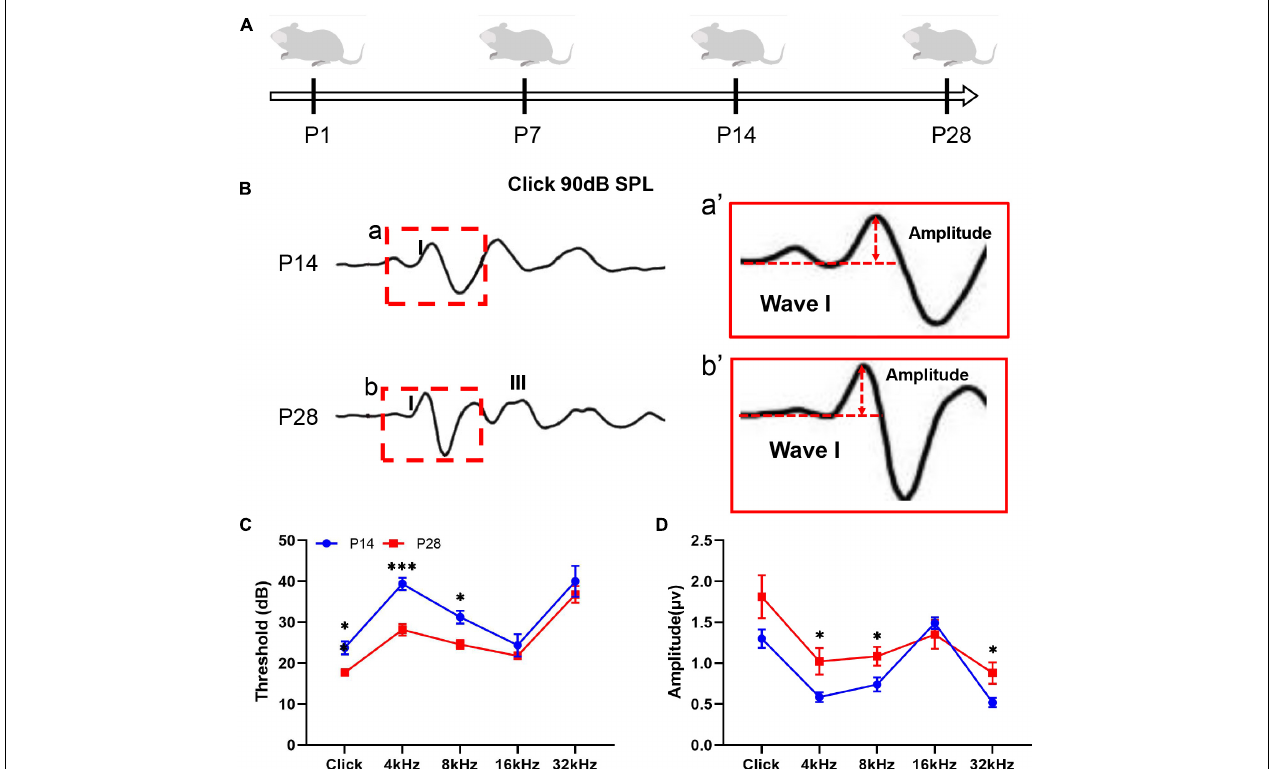
FIGURE 1 | Hearing detection corresponding to developing cochlea. (A) Schematic diagram of the experimental procedure and time points for hearing detection. Hearing function in the mice was estimated by detecting the ABR threshold and ABR wave I amplitude at P14 and P28. (B,a,b) A visible ABR waveform was observed at P14 and P28; the red dashed frame indicates ABR wave I. (a (cid:48) ,b (cid:48) ) A larger amplitude of ABR wave I was found at P28 than at P14. (C) Compared with P14, significantly reduced ABR thresholds at P28 were identified at click, 4 kHz, and 8 kHz (* p < 0.05; *** p < 0 . 001). (D) Compared with P14, significantly increased ABR wave I amplitudes were observed at P28 at 4, 8, and 32 kHz (* p < 0 . 05). ABR, auditory brainstem response.